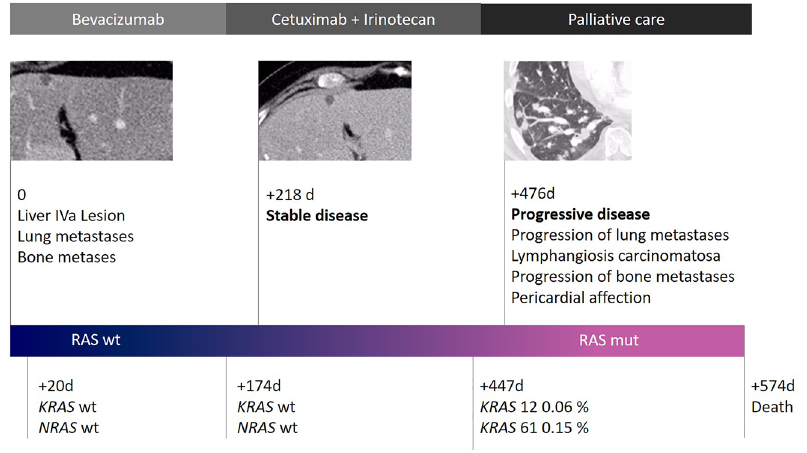
Figure 1: Liquid profiling used for companion diagnostics and detection of